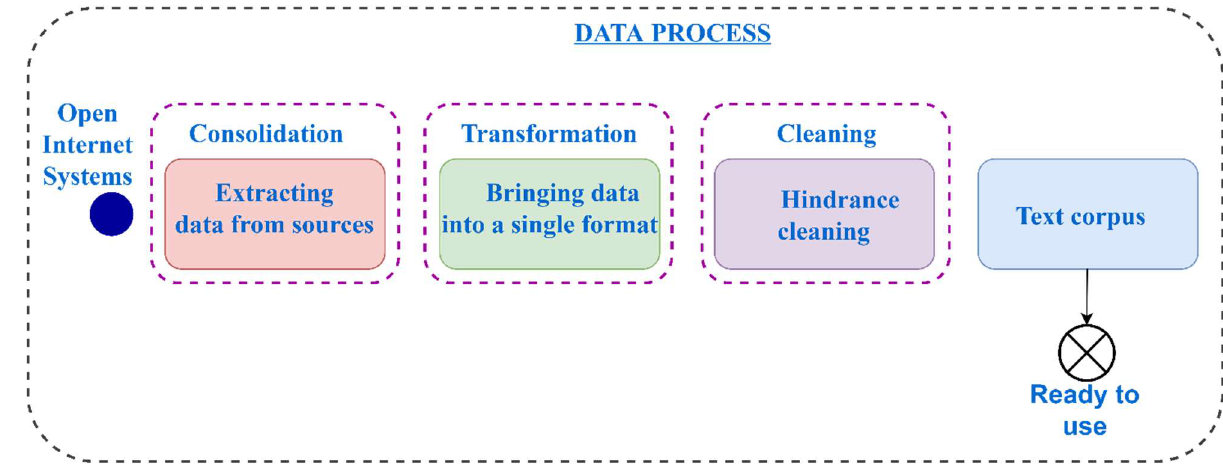
Figure 1. Generalized scheme of data processing.